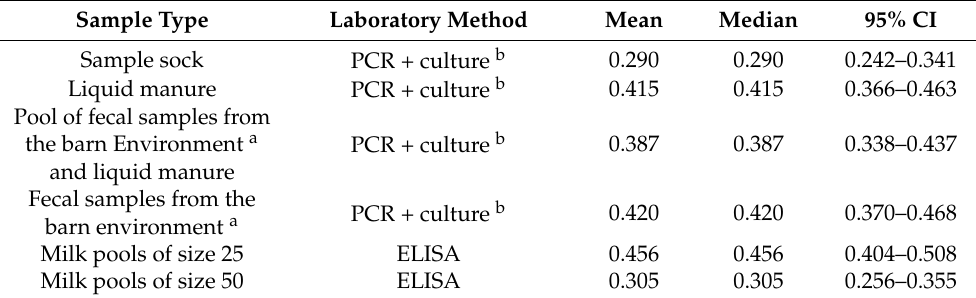
Table 1. Posterior mean, median, and 95% credible interval (CI) of the sensitivity regarding the detection of MAP at herd level (one sampling event) in large low-prevalence dairy